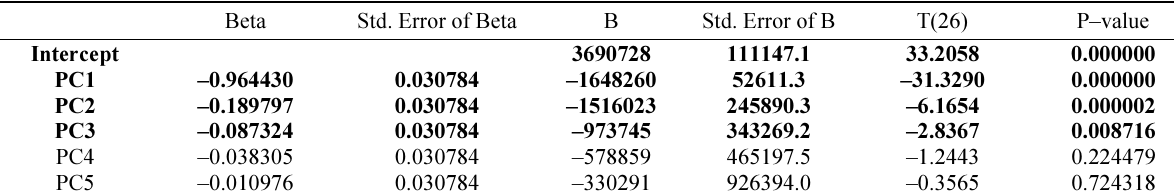
Table 5. Regression summary for capital cost ($) for backhoe shovel Beta Std. Error of Beta